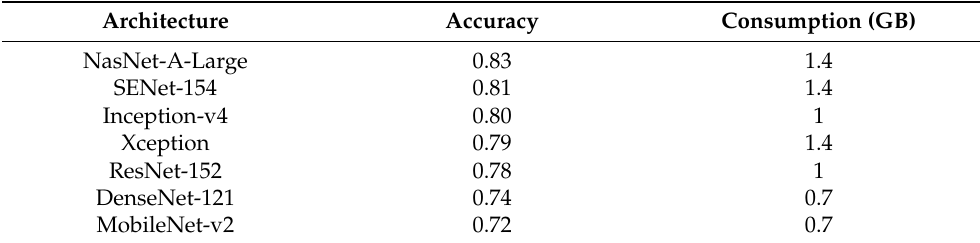
Table 4. Comparative study of state-of-the-art